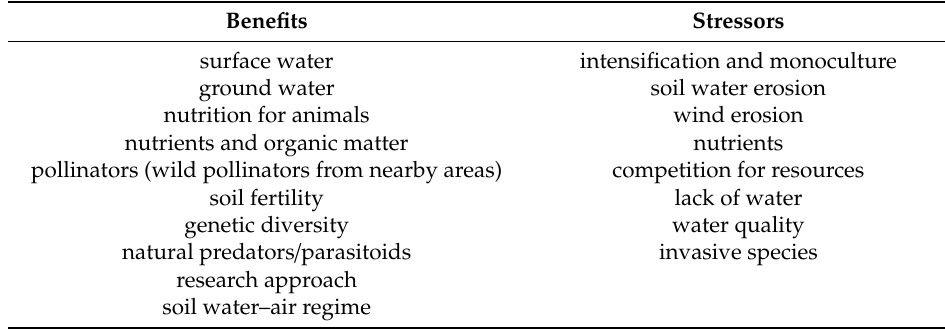
Table 4. Analysis of the benefits of the Caia River for agriculture and stressors from agriculture to the Caia